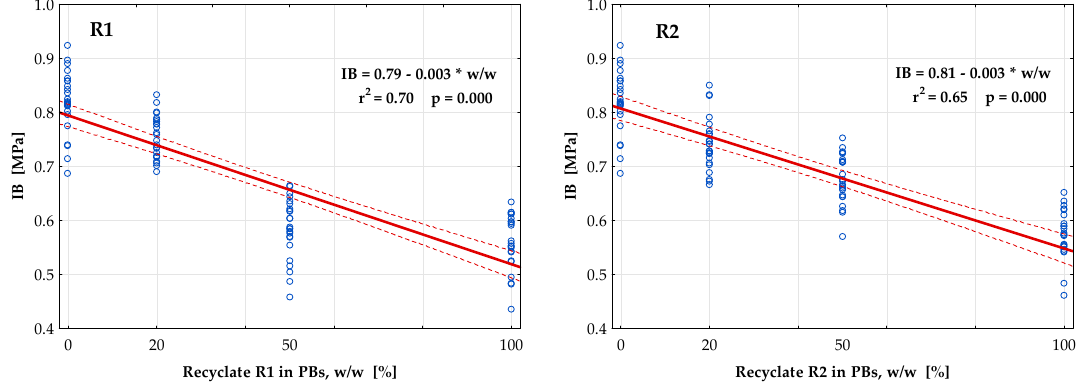
Figure7. Internalbonds(IB)of PBscontainingdi ff erenttypes(R1orR2)andamounts Figure 7. Internal bonds (IB) of PBs containing different types (R1 or R2) and amounts of wood recyclates.